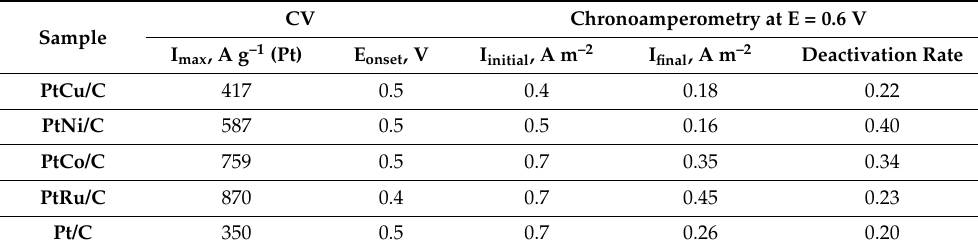
Figure 8. The CVs of the PtM/C and Pt/C catalysts, the potential sweep rate is 20 mV s − 1 , the electrolyte is 0.5 M CH 3 OH + 0.1 M HClO 4 saturated with Ar at atmospheric pressure ( a ); the chronoamperograms of the methanol electrooxidation for the PtM/C and Pt/C catalysts at the potential of 0.6 V ( b ). Table 3. The parameters characterizing the catalysts’ behavior in the